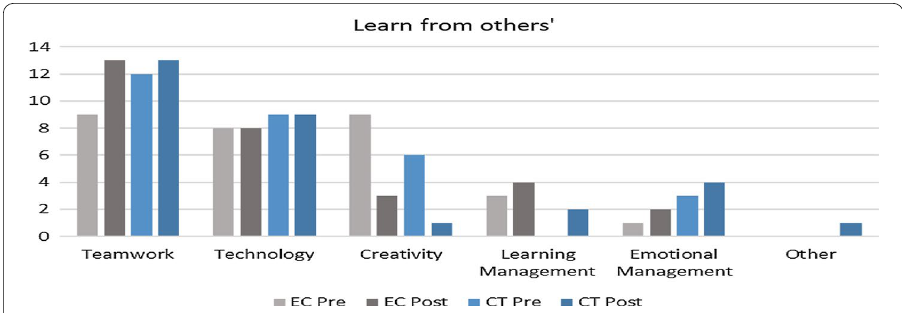
Fig. 6 Change in perception pre and post-intervention based on aspects learn from teammates